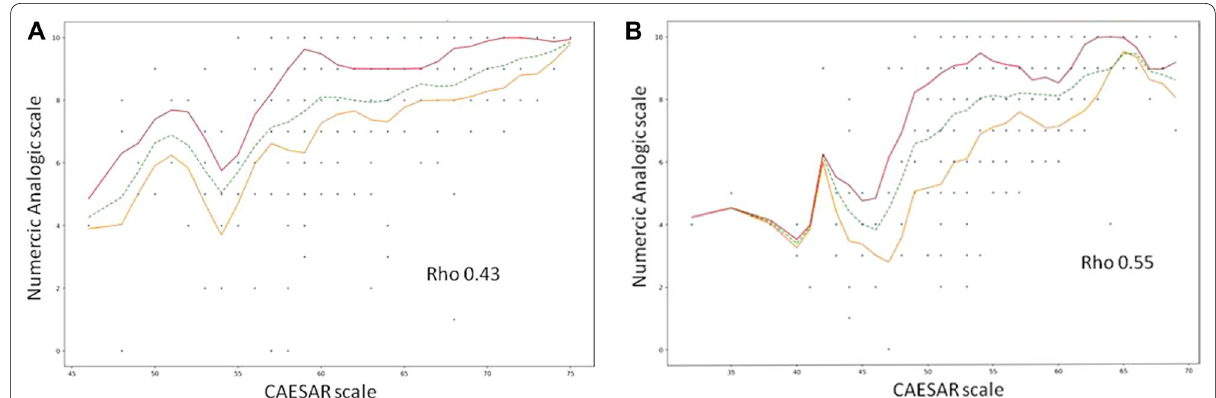
Fig. 1 A Correlation between CAESAR score and Numeric Analogic Scale for physicians. B Correlation between CAESAR score and Numeric Analogic Scale for